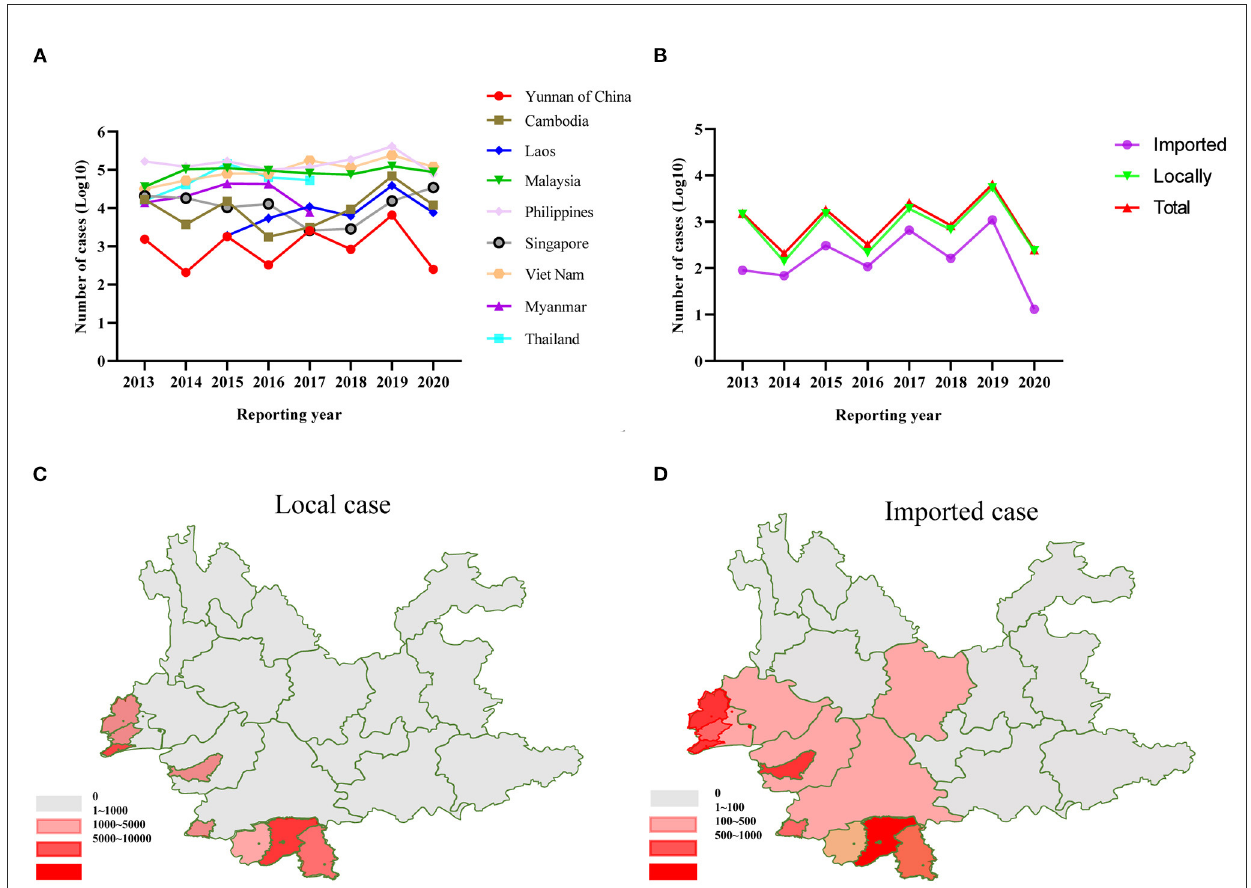
FIGURE1 (A) The number of dengue cases in Yunnan Province of China and neighboring countries from 2013 to 2020. (B) The number of local cases and imported cases in Yunnan Province of China from 2013 to 2020. (C) Regional distribution map of local cases from 2013 to 2020 in Yunnan, China. (D) Regional distribution map of imported cases from 2013 to 2020 in Yunnan, China.